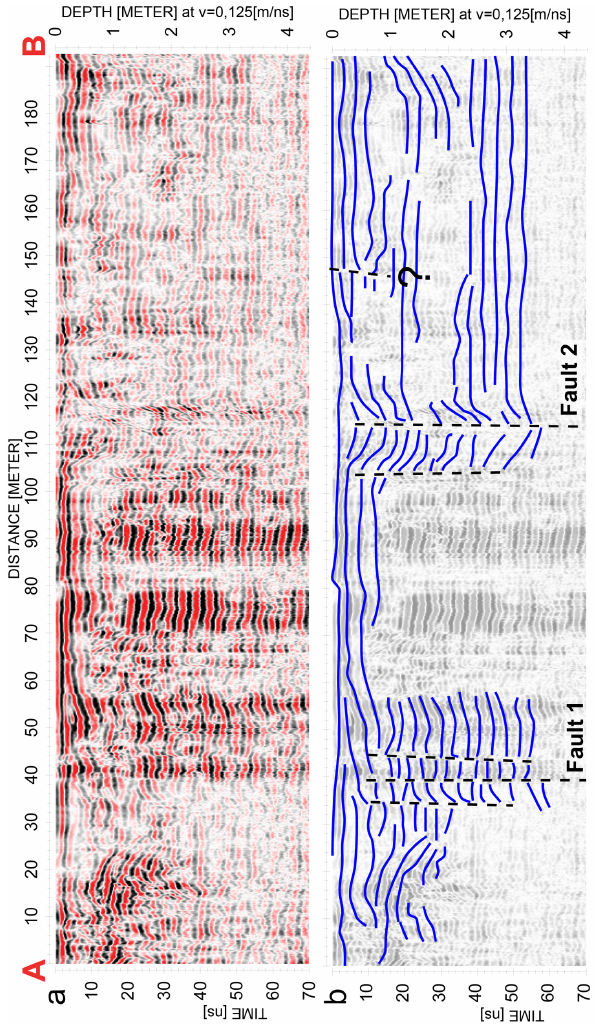
Figure 14. Devil’s Kitchen WNW–ESE profile. (a) 400MHz pro- file without interpretation. (b) Profile with interpretation (blue lines: interpreted layers; dashed line: interpreted faults). Faults 1 and 2 are also outlined in Fig.